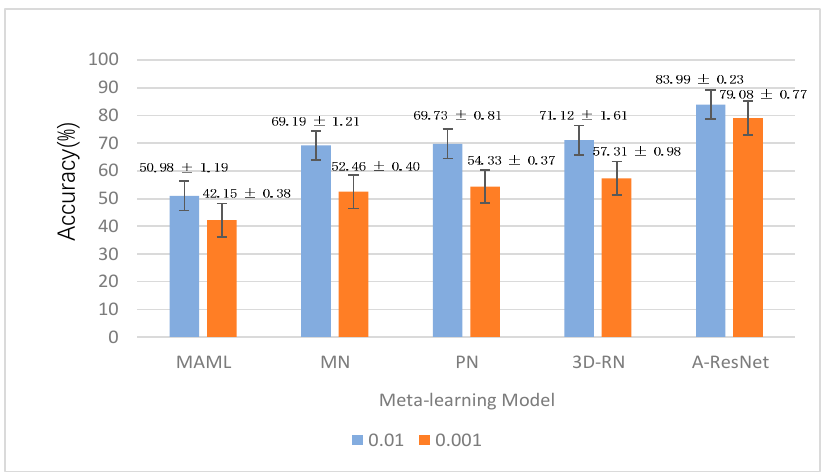
Figure 11. The accuracy of the A-ResNet model and other models under the 1-shot case.